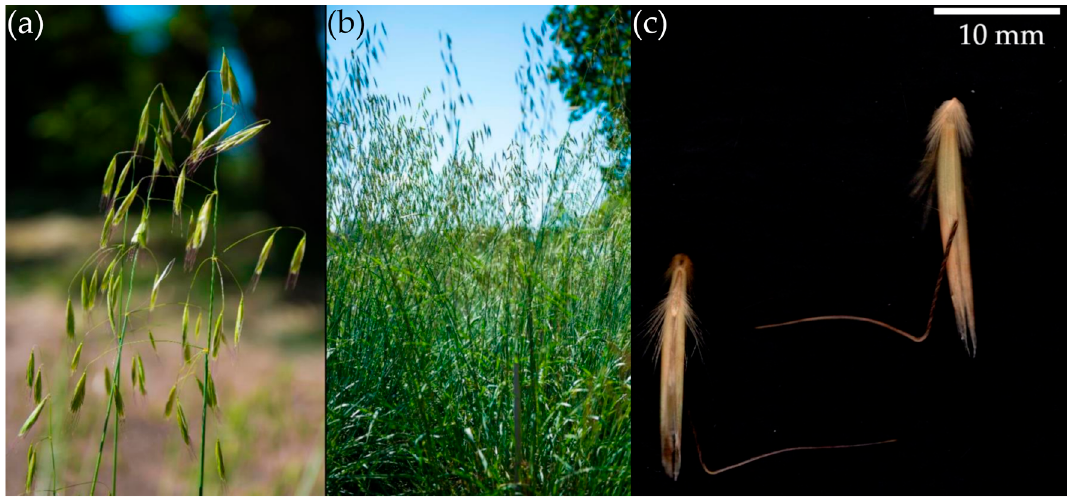
Figure 1. Morphology of Avena macrostachya Bal. ex Cross. et Durieu, ( a ) panicles (PL 52406), ( b ) the overall plant appearance (PL 52406), ( c ) grain morphology (PL 52409).